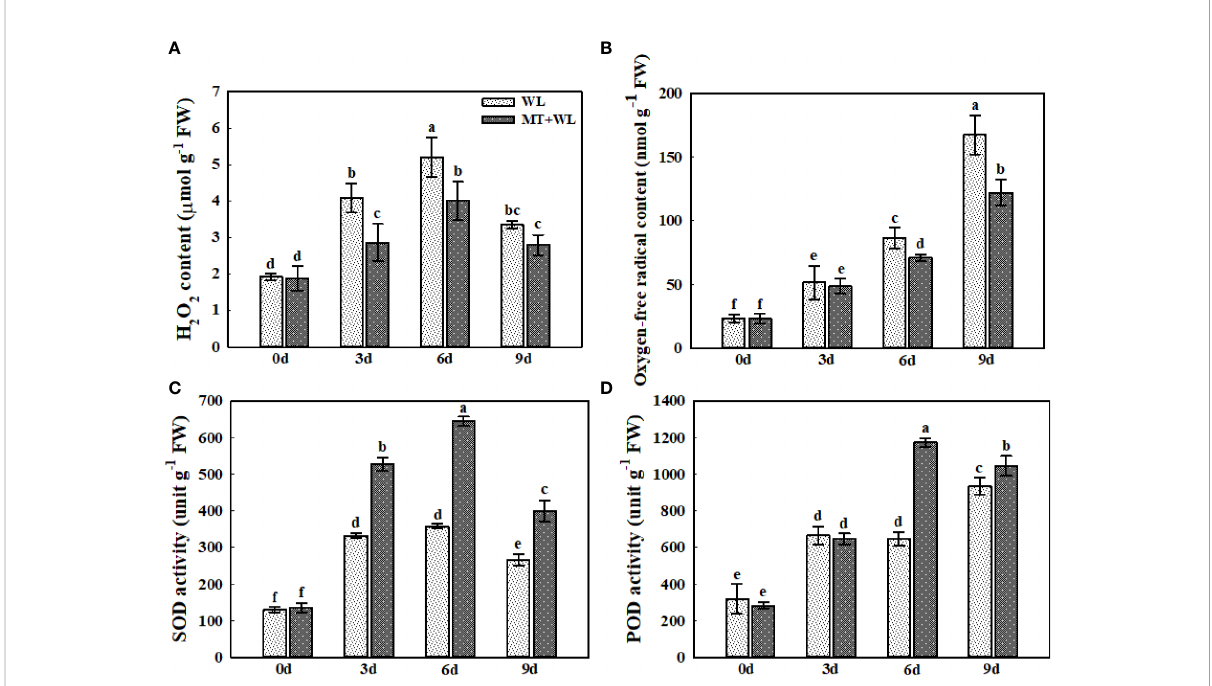
FIGURE 4 Exogenous melatonin alleviated the ROS damage in the roots of kiwifruit plants under waterlogging stress. (A) H 2 O 2 and (B) O 2 − concentrations in the roots of CK, MT, WL, and MT+WL plants. Activities of (C) superoxide dismutase (SOD) and (D) peroxisome (POD) in the roots of CK, MT, WL, and MT+WL plants. Data are shown as the means of three replicates with SEs. Different letters indicate signi fi cant differences between treatments, according to one-way ANOVA and Tukey ’ s multiple range test (P <